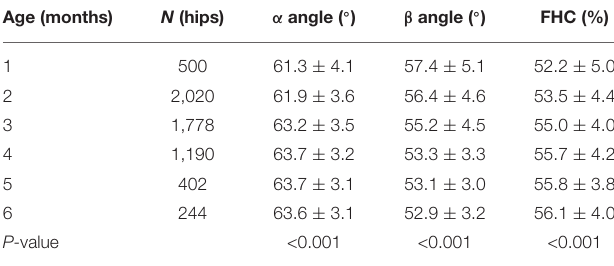
TABLE 3 | Comparison of α angle, β angle, and femoral head coverage of the hips among ages of months in normal infants.